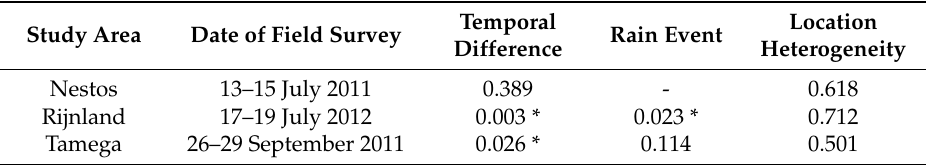
Table 5. Analysis of variance and the effect of various parameters on the residuals at all sites ( p -values). Study